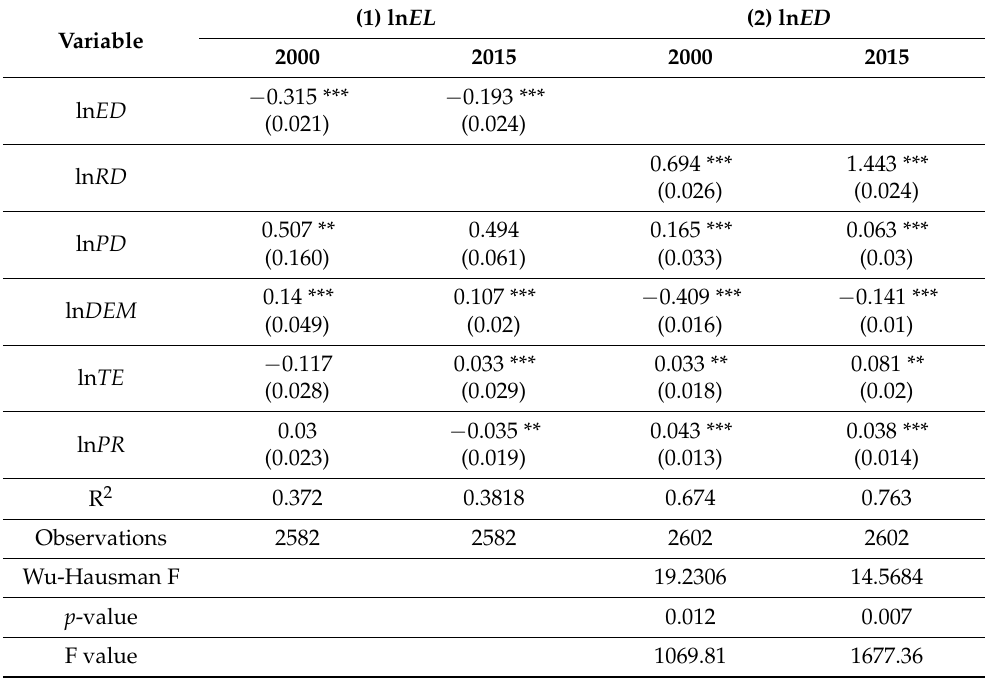
Table 4. Parameter estimation of the 2SLS regression in 2000 and